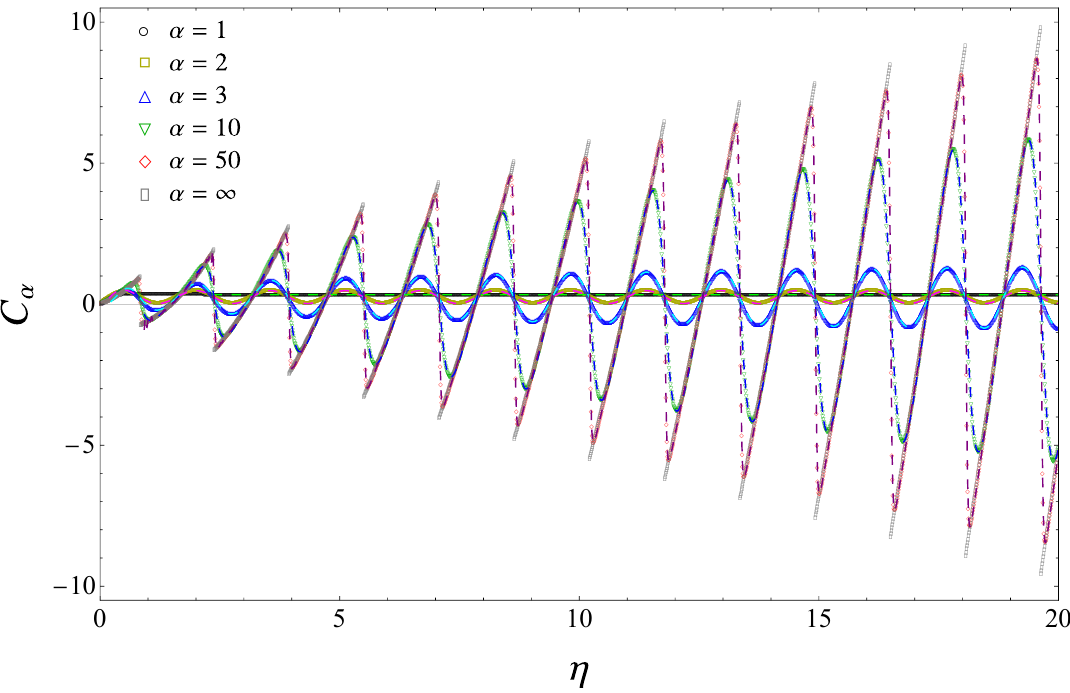
Figure 12. The quantities C α in (5.10) for different values of α